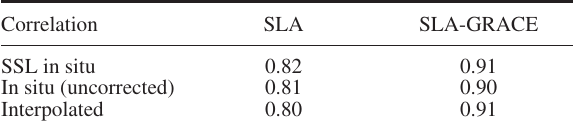
t able 3. – Correlations between spatially averaged SLA from al- timetry before and after the removal of the mass component from GRACE and the SSL from in situ profiles (both corrected and un- corrected) and interpolated data over the whole Mediterranean basin for the period 2003-2008.